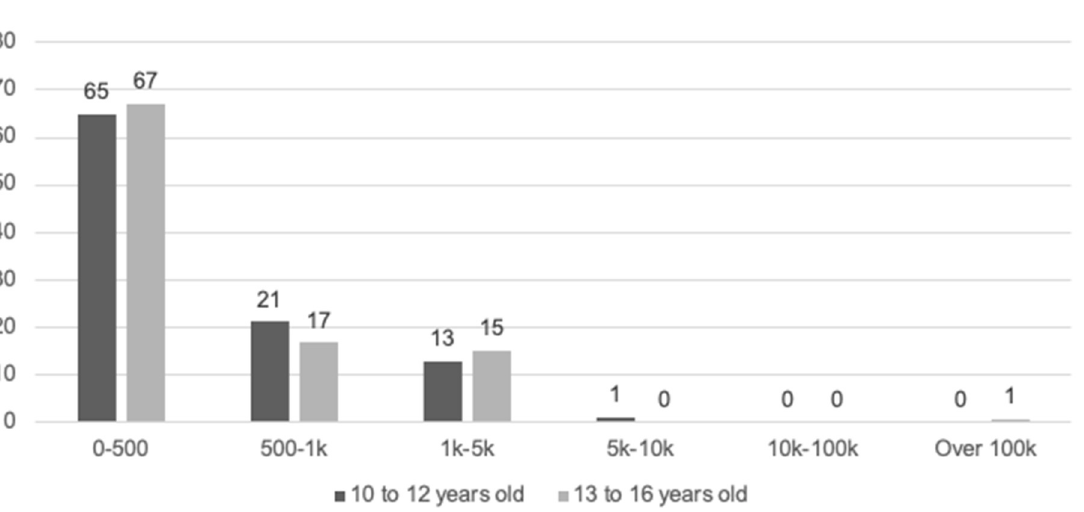
Figure 4. Number of followers on TikTok (in percentage). We asked our respondents about their preferences regarding TikTok content (Q11), observable in Figure 5. The favorites are choreography videos (enjoyed by 80.4% of our sample), funny videos (liked by 79.8%) and songs (enjoyed by 72.6%), consistently with previous research (Bresnick 2019). Native TikTok formats, such as POV’s (short dramatic